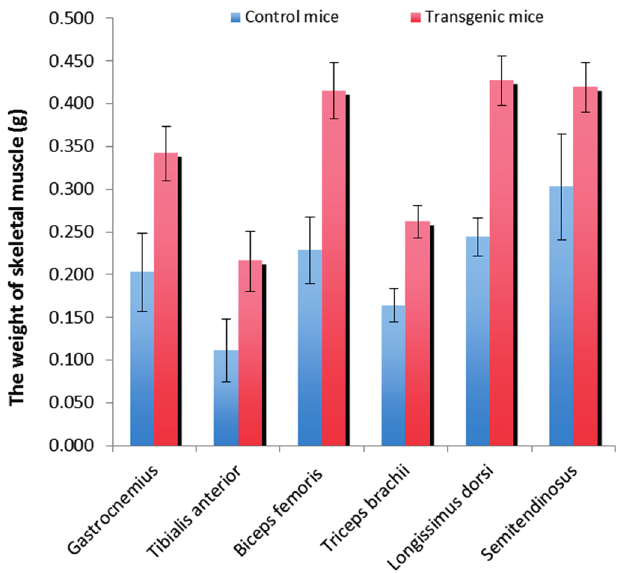
Figure 1. The skeletal muscle weights of the transgenic mice and wild-type littermate